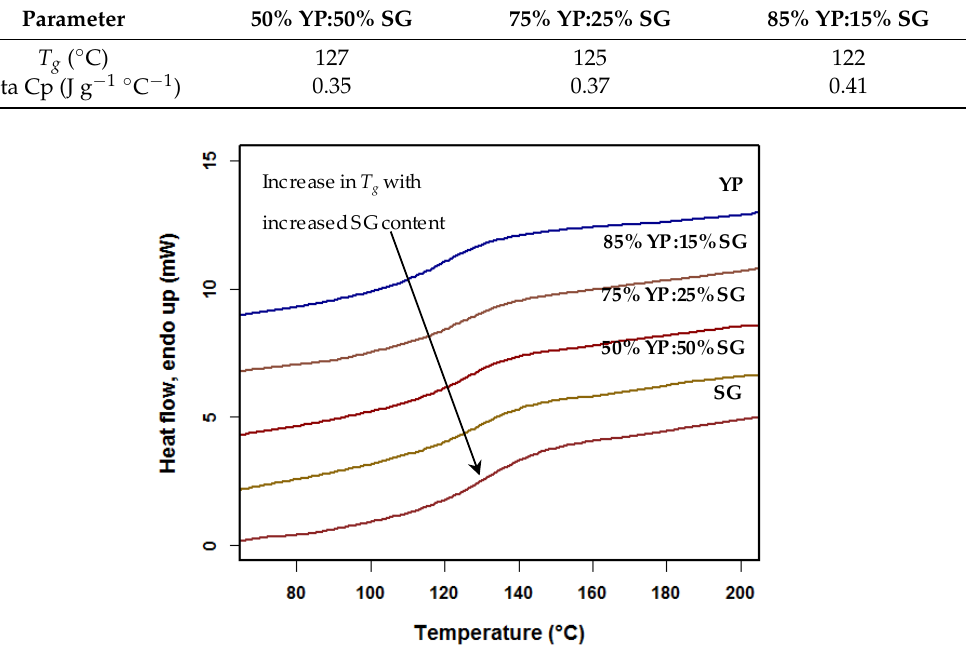
Table 4. T g of switchgrass (SG) and yellow polar (YP) lignin blends ( w/w ).